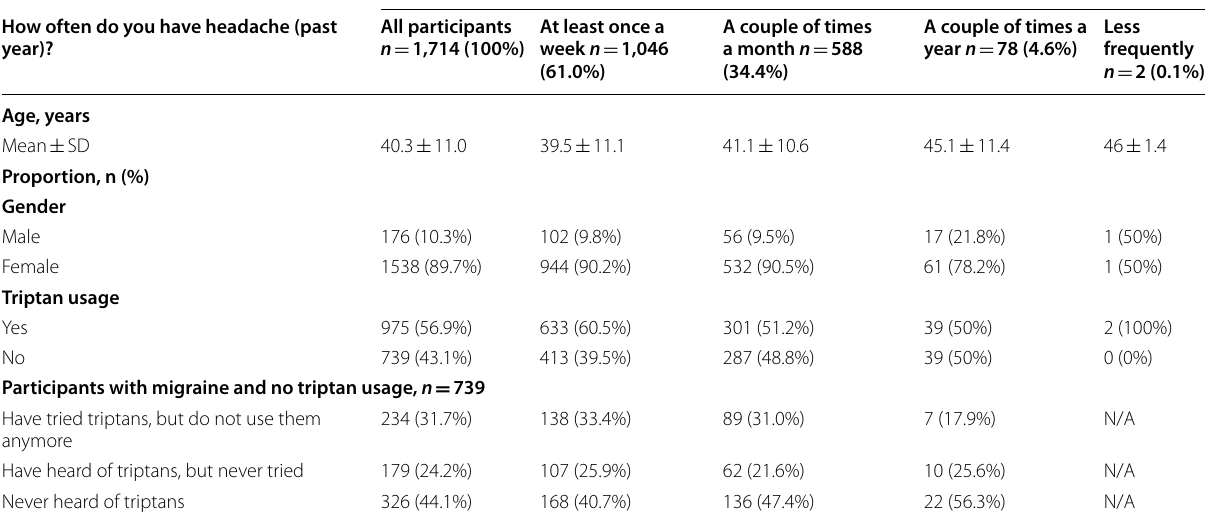
Table 4 Triptan usage in respondents with migraine